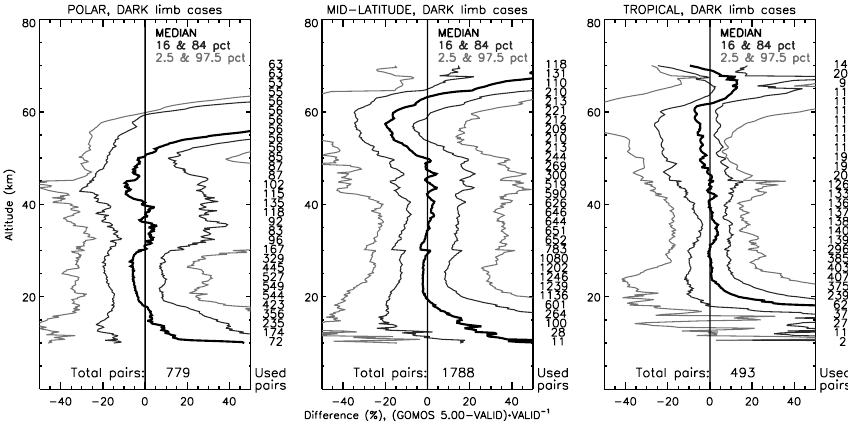
Fig. 8. As Fig. 4 showing the validation results for the different latitude regions. Left panel: polar cases; middle panel: mid-latitude regions; right panel: tropical Figure 8: As Figure 4 showing the validation results for the different latitude regions. Left 3 panel: polar cases; middle panel: mid-latitude regions; right panel: tropical region.4